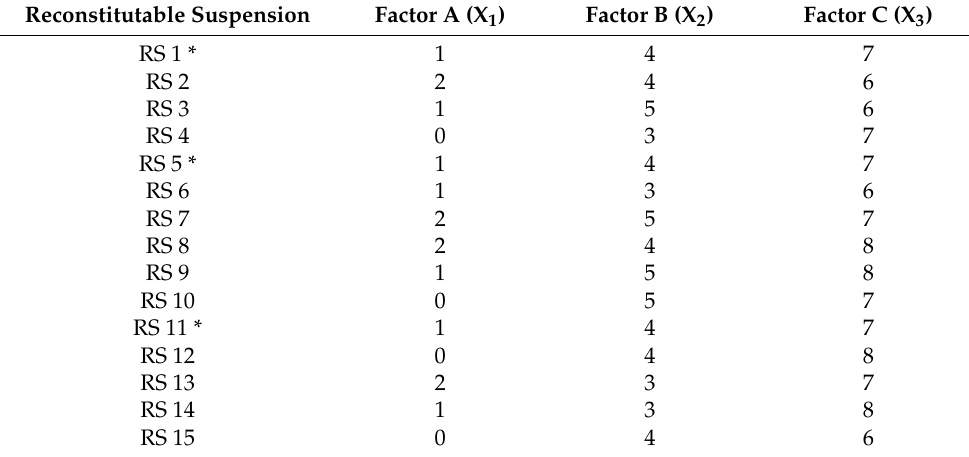
Table 2. Box–Behnken experimental design layout. Reconstitutable